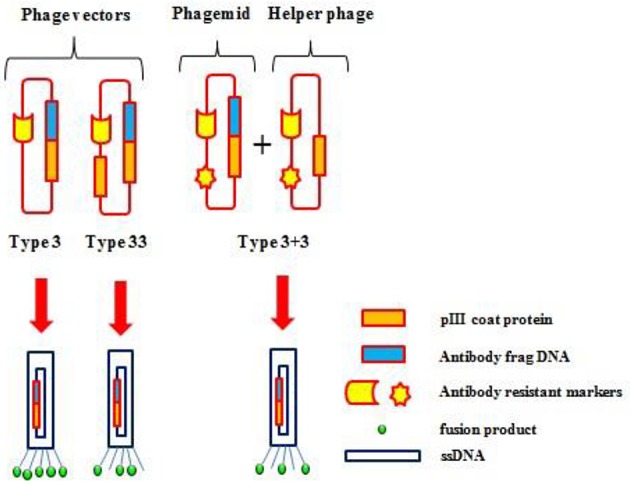
Various phage display systems. Gene pIII is represented as an orange box, the foreign DNA insert as a blue box, and the fusion products as a green circle.